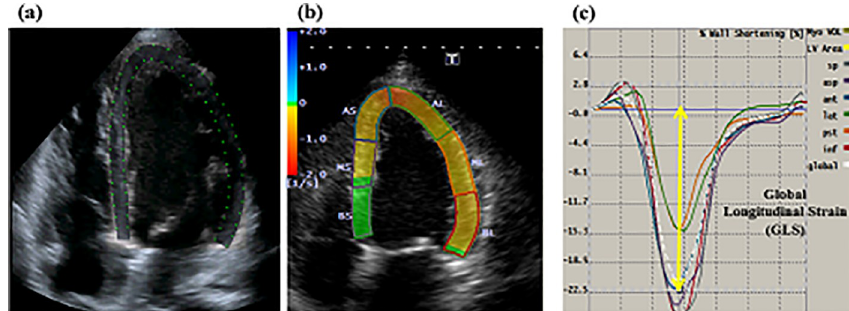
Fig 2. Example of the measurement of left ventricular (LV) global longitudinal strain (GLS) with a two- dimensional speckle-tracking echocardiography (2DSTE) in a patient with chronic total occlusion who underwent successful percutaneous coronary intervention (PCI). Figure (a) and (b) showed apical four-chamber view. White broken lines indicated the LV global strain curves for GLS. Yellow arrow indicated the mean LV global peak longitudinal strain; GLS: − 22.5%